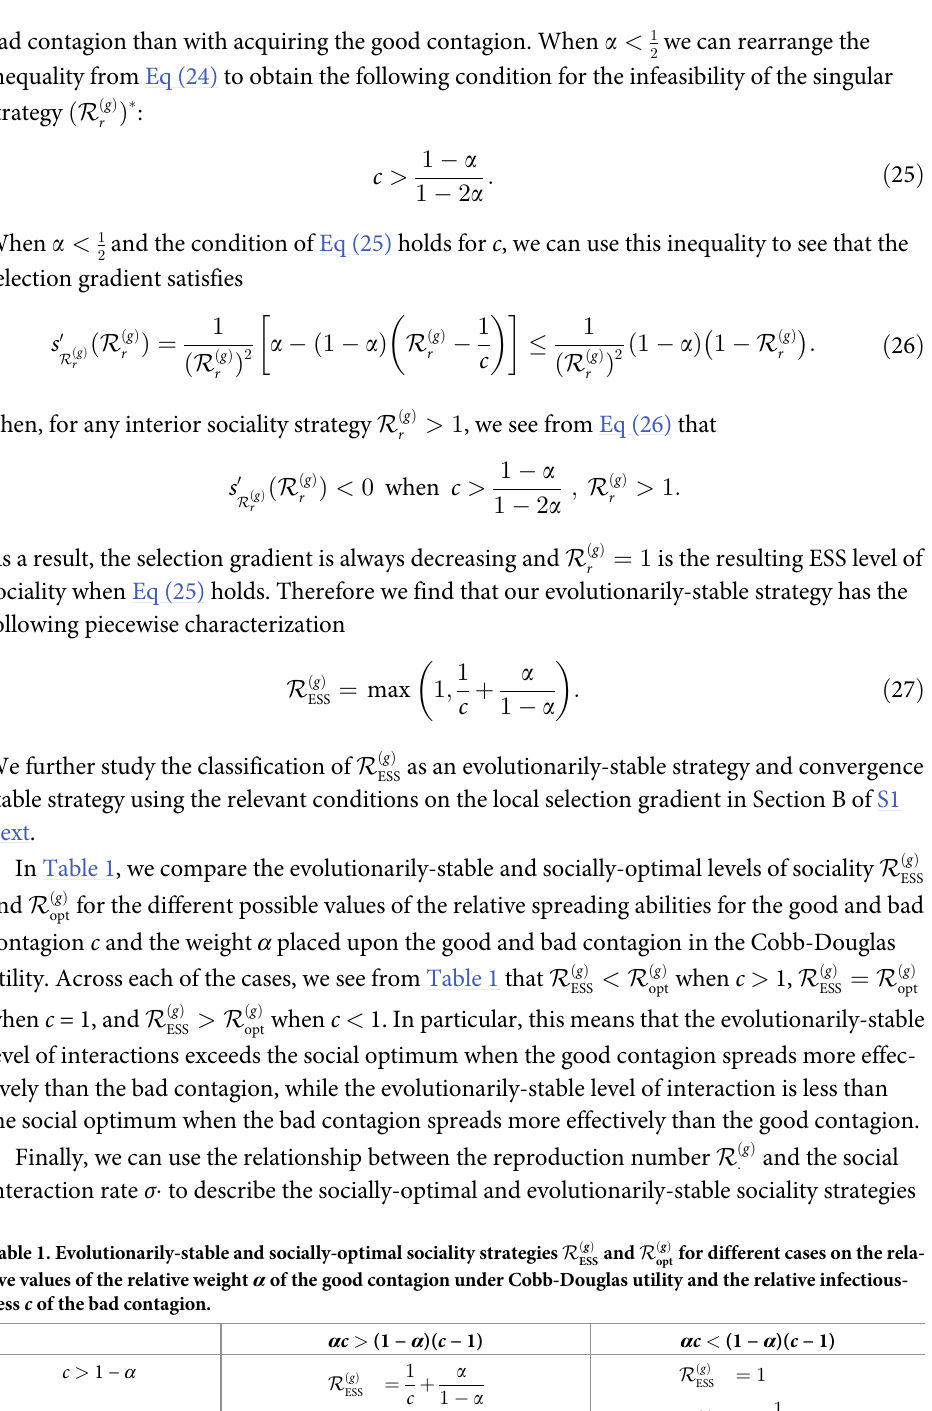
and R ð g Þ for different cases on the rela- ESS opt